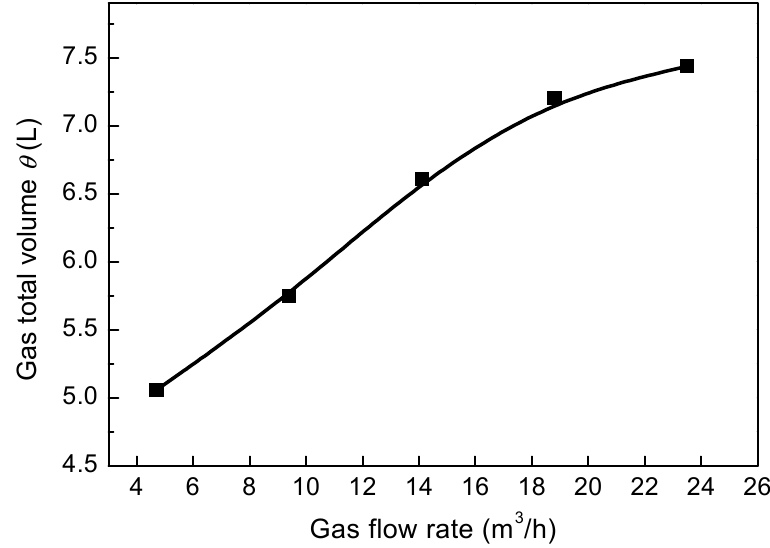
Figure 16. Effect of different gas flow rates on the predicted gas total volume, θ , in the bath.